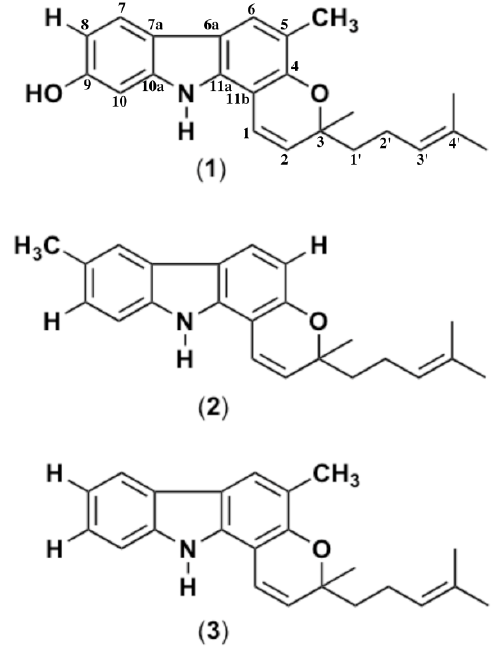
Figure 1. Chemical structures of carbazole alkaloids (mahanine ( 1 ), mahanimbicine ( 2